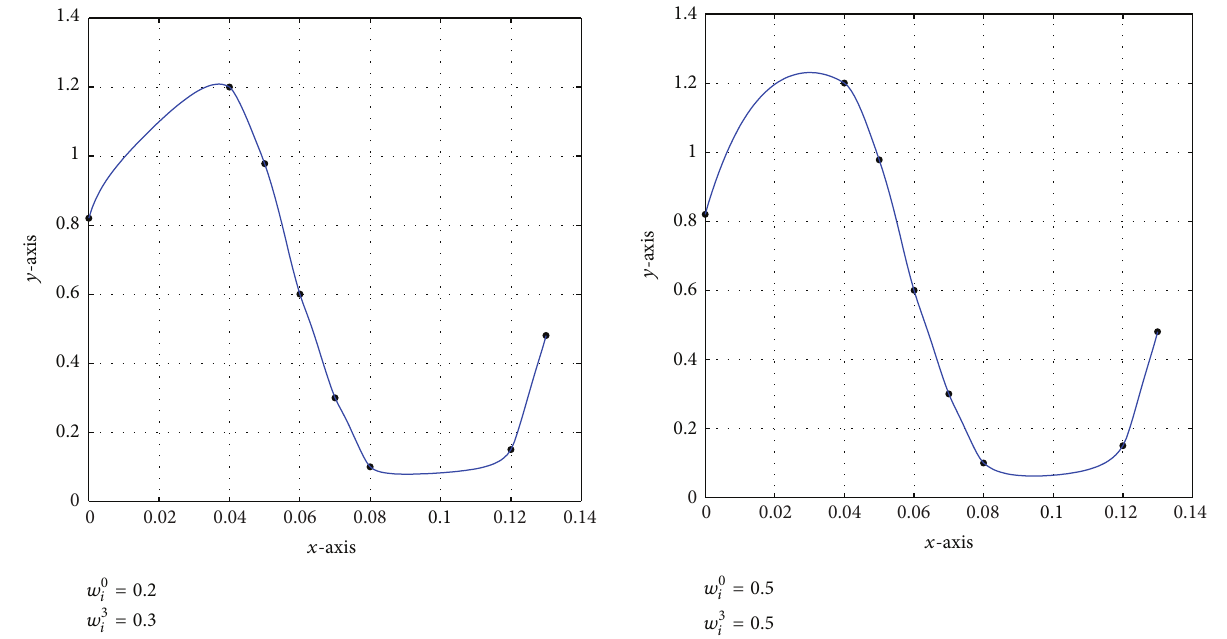
Figure 2: A 𝐶 1 positivity preserving curve with different values of free parameters.